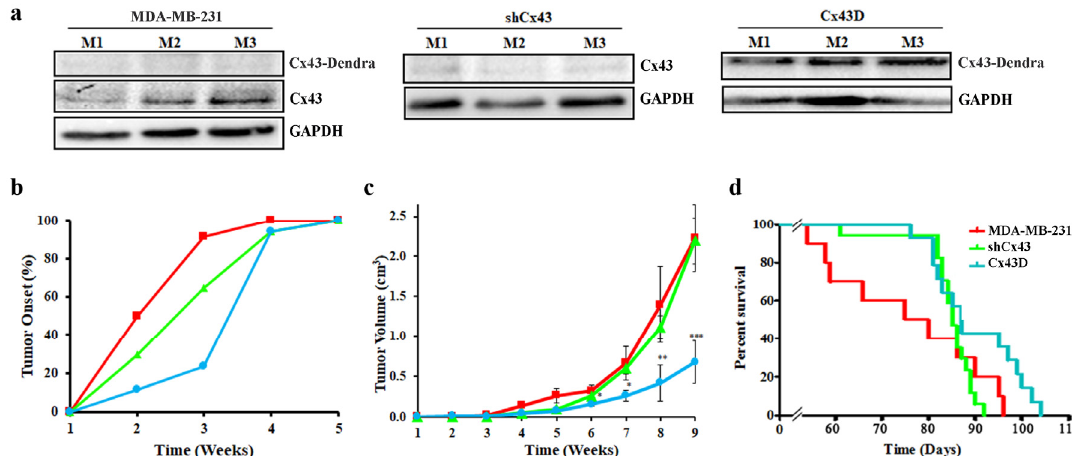
Figure 6. Cx43 over-expression delays tumor onset, decreases tumor volume and increases overall survival. ( a ) Western blotting of Cx43 in primary tumor tissues from three different mice, 9 weeks post-injection with parental MDA-MB-231, shCx43 or Cx43D cells. ( b ) Graph showing primary tumor onset over time. Mice were monitored for any palpable tumors at the site of injection. Percentage of mice with first palpable tumor occurrence was plotted against time. ( c ) Graph displaying tumor volume (in cm 3 ) measured using a Vernier caliper, on a weekly basis throughout the experimental duration. ( d ) Kaplan-Meier survival curves of mice injected with parental MDA-MB-231, shCx43 or Cx43D cells. Mice were monitored daily until moribund state or death was reached. * p < 0.05; ** p < 0.01; *** p < 0.001.